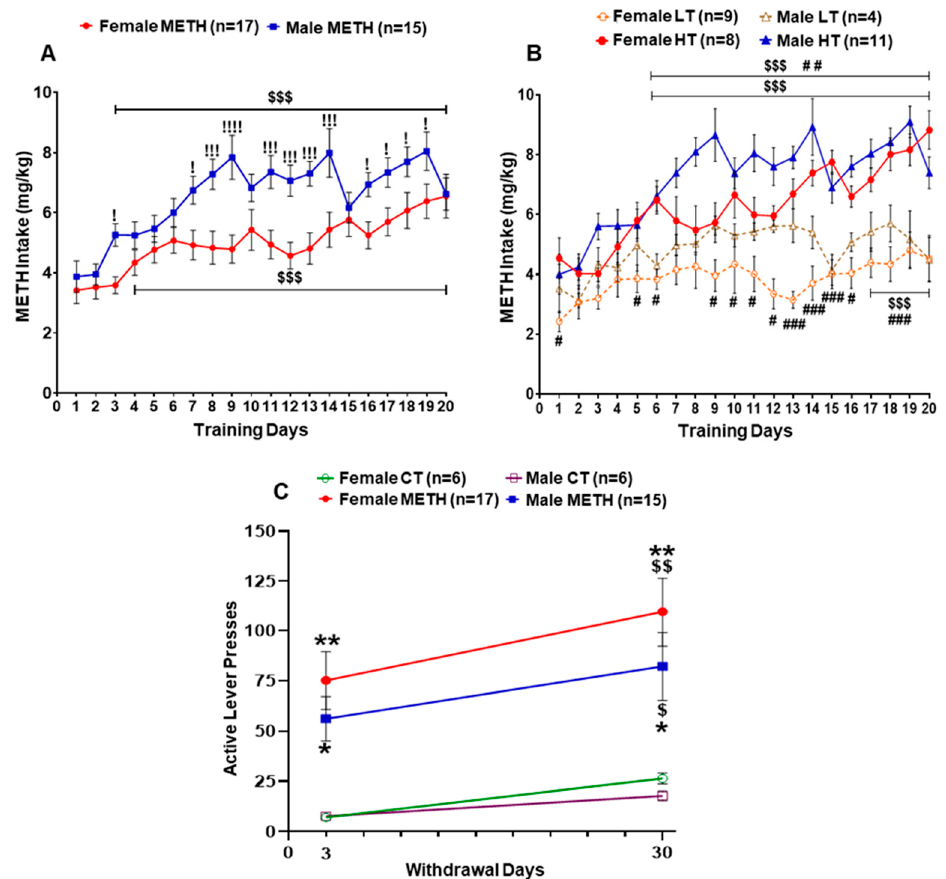
Figure 1. Behaviors of female and male rats after METH SA and during METH-seeking tests. ( A ) Patterns of daily METH intake behaviors by female and male rats. ( B ) METH intake by female and male low and high METH takers. ( C ) Drug-seeking behaviors by female and male rats at WD3 and WD30. Key to statistics: * p < 0.05, ** p < 0.01, female and male METH groups compared with respective saline groups; ! p < 0.05, !!! p < 0.001, comparison of male METH group with female METH group; $ p < 0.05, $$ p < 0.01, $$$ p < 0.001, comparison of daily METH intake of female and male rats compared to METH intake on the first day of SA or comparison of active lever pressing on WD30 compared to WD3. # p < 0.05, ## p < 0.01, ### p < 0.001, comparison between female or